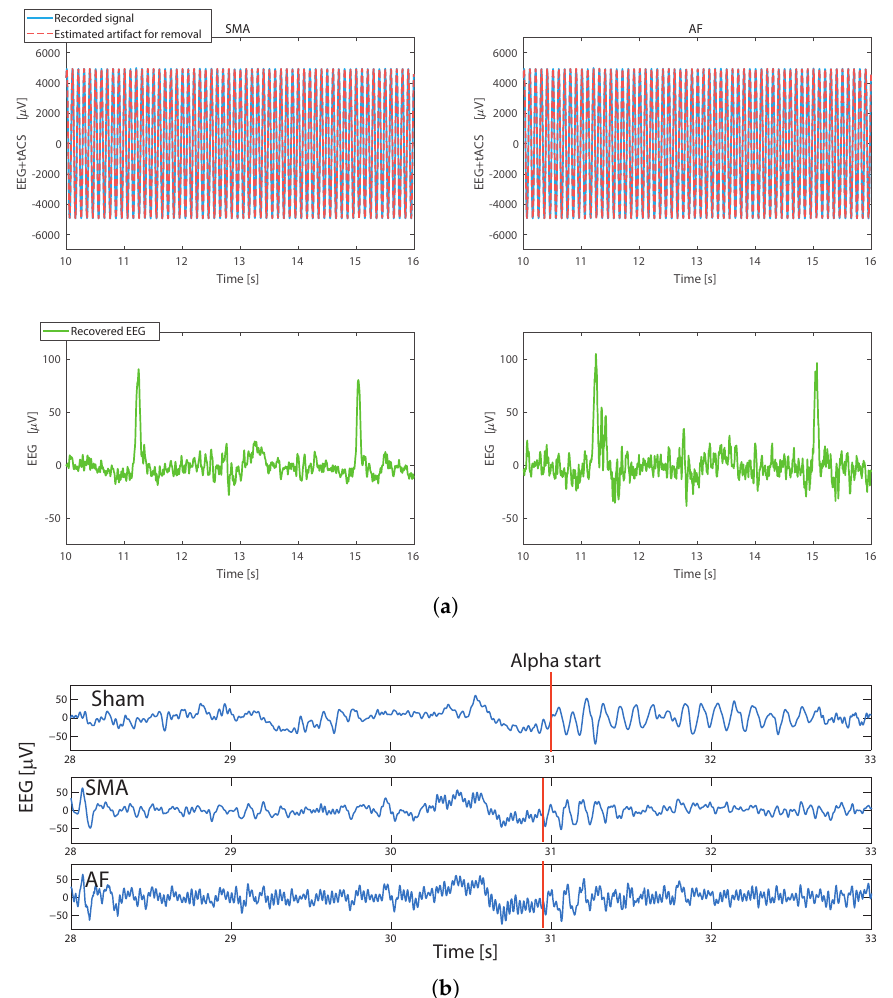
Figure 8. Time domain EEG after artifact removal. ( a ) The measured artifacts using the two algorithms and the recovered EEG during an eye blink. 10 Hz, 0.25 mA stimulation. ( b ) EEG data during the alpha task protocol, at PO8, for a single subject showing sham and artifact removed data with tACS at 40 Hz, 1 mA amplitude. Eyes are closed at the 30 s mark. Then bursts of alpha are seen for both sham and stimulation using all three artifact removal approaches. Note that the sham and stimulation are different trial runs and thus the EEG trace for sham and the other figures are not expected to be